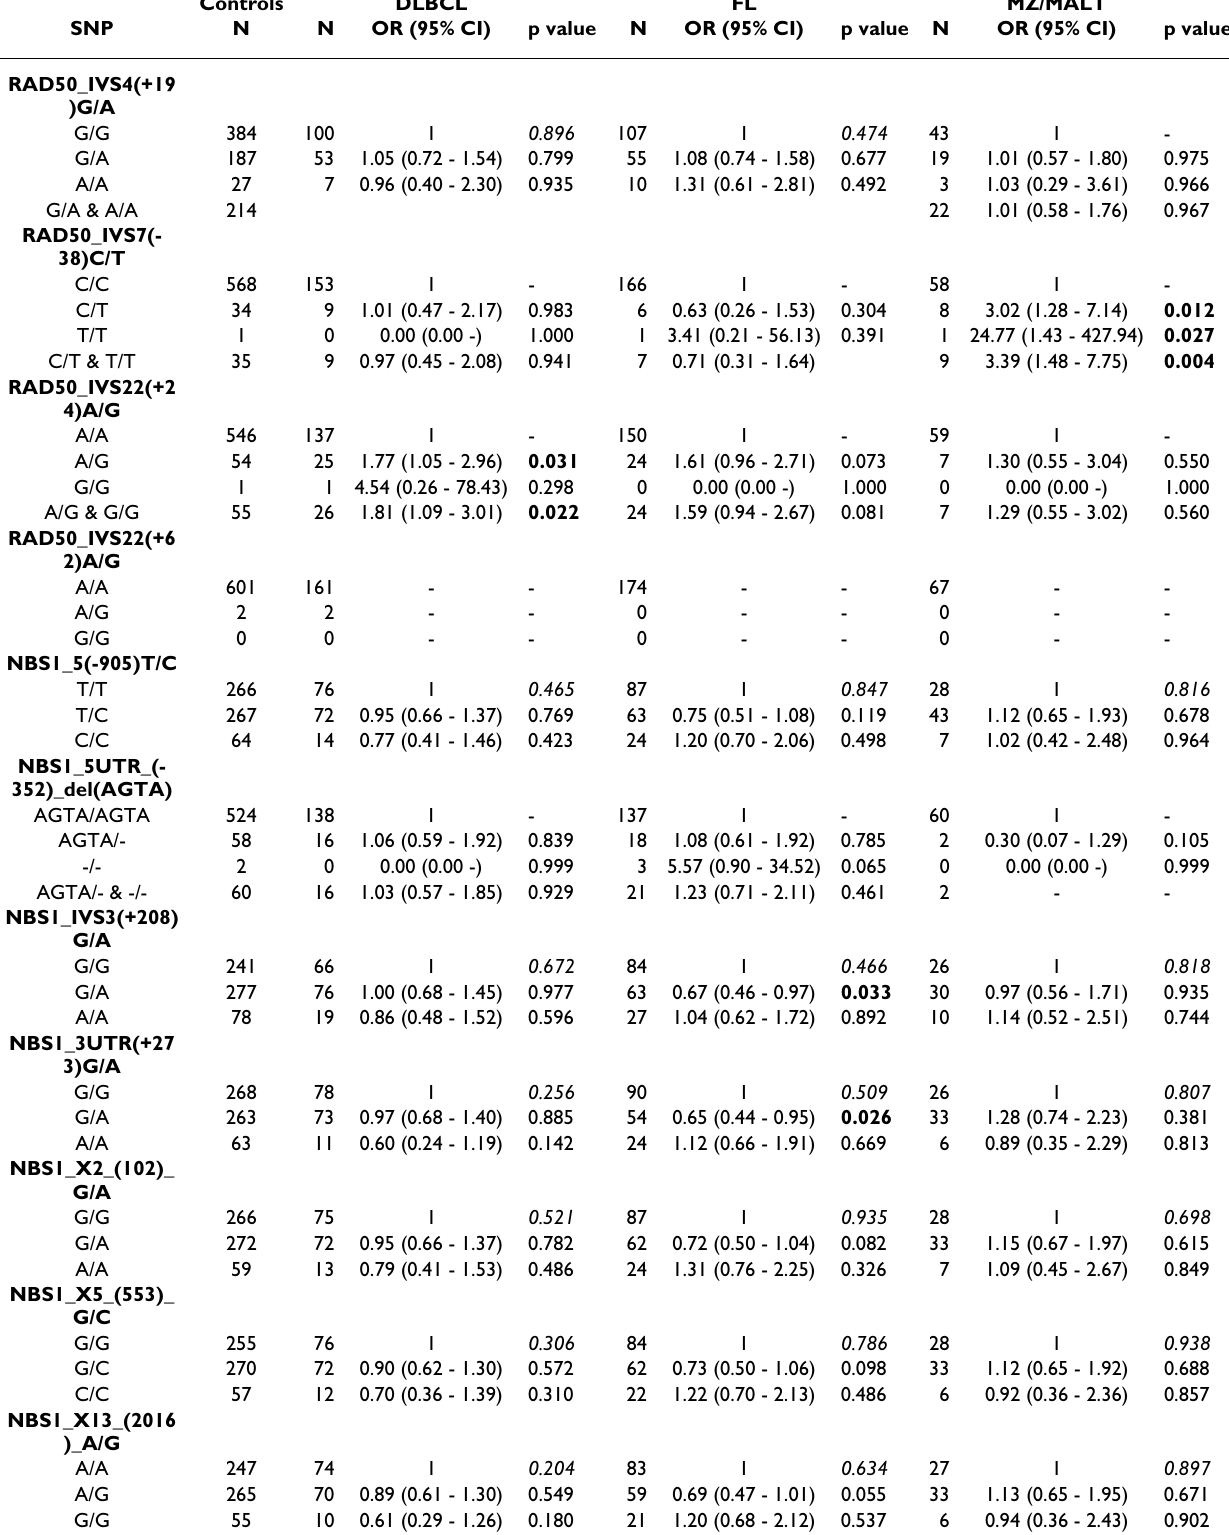
Table 3: Regression analysis in European samples for all SNPs in selected